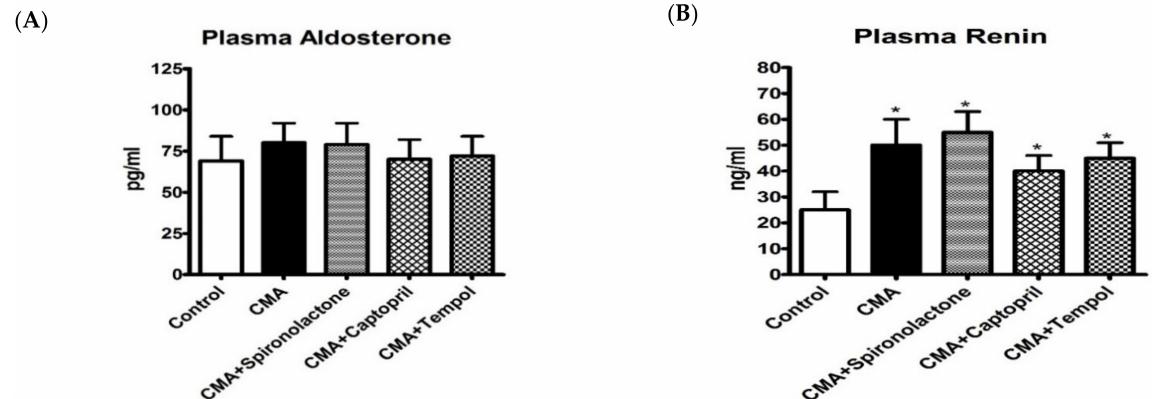
Figure 8. Plasma aldosterone ( A ) and plasma renin ( B ) analysis. Each bar represents values expressed as mean ± SEM. The changes in plasma aldosterone and renin were considered significant when * p < 0.05 (control vs. CMA) groups. The data were analyzed using one-way ANOVA followed by Tukey’s multiple comparison test among all five